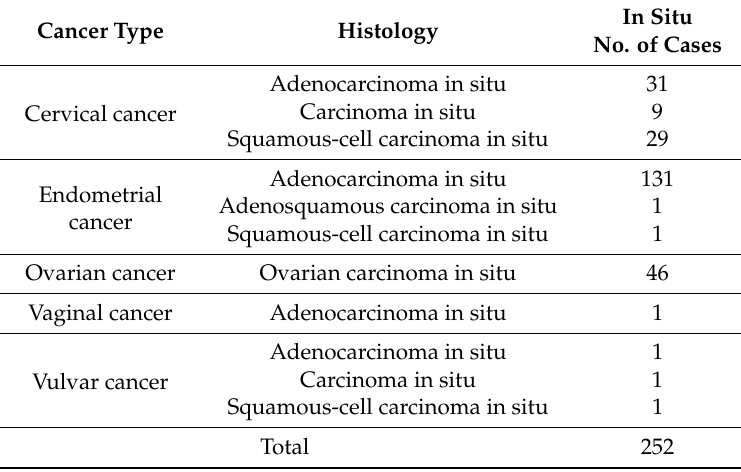
Table A1. In situ histopathological